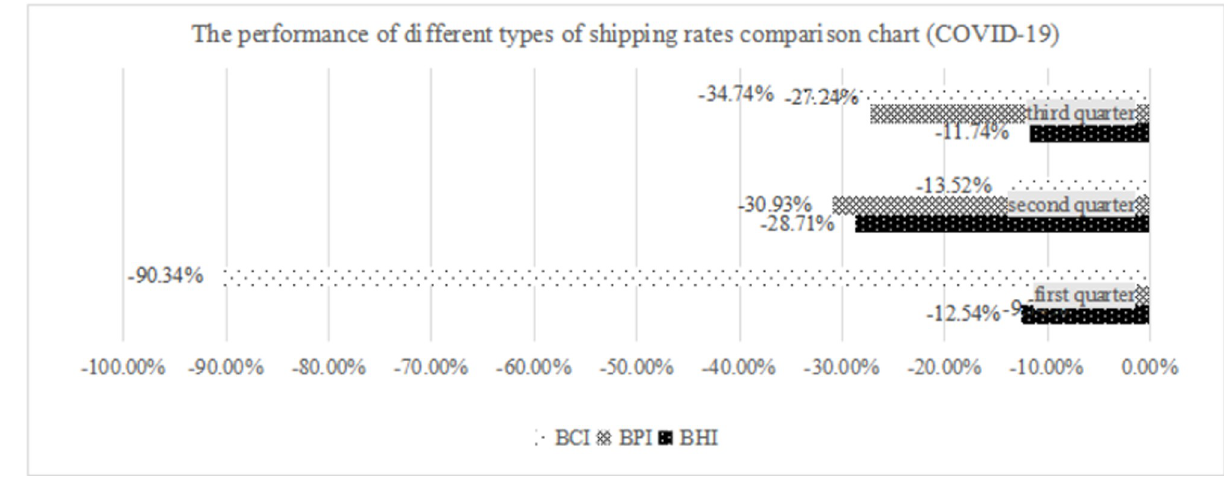
Fig 8. The performance of different types of shipping rate comparison charts (COVID-19).